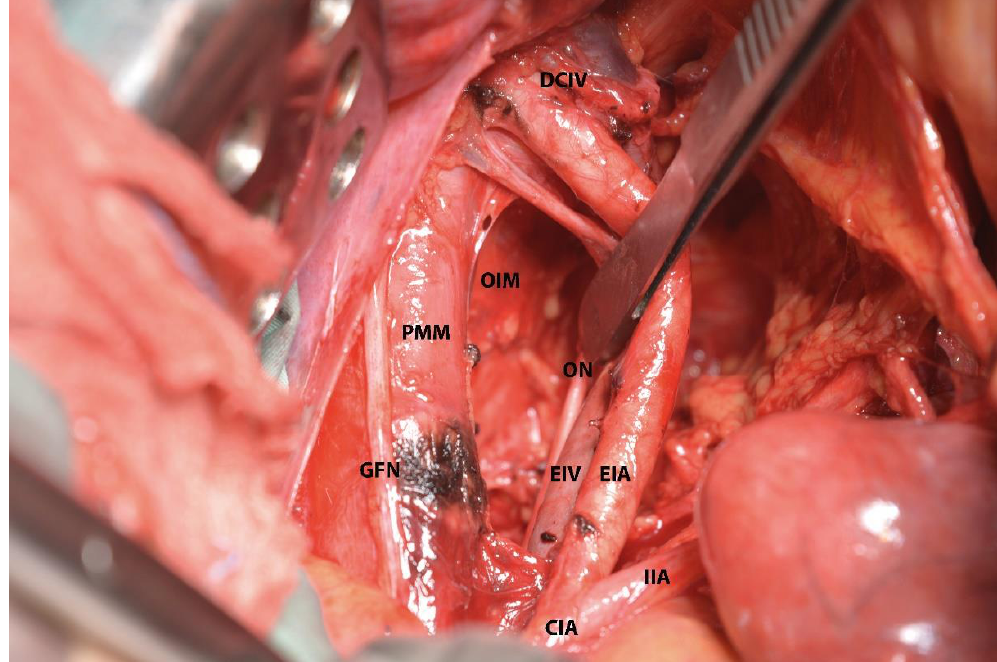
Figure 12. Medial psoas space (left pelvic sidewall). The inferiorlimit of the space — the obturator nerve is retracted medially. PMM — psoas major muscle; GFN — genitofemoral nerve; EIA — external